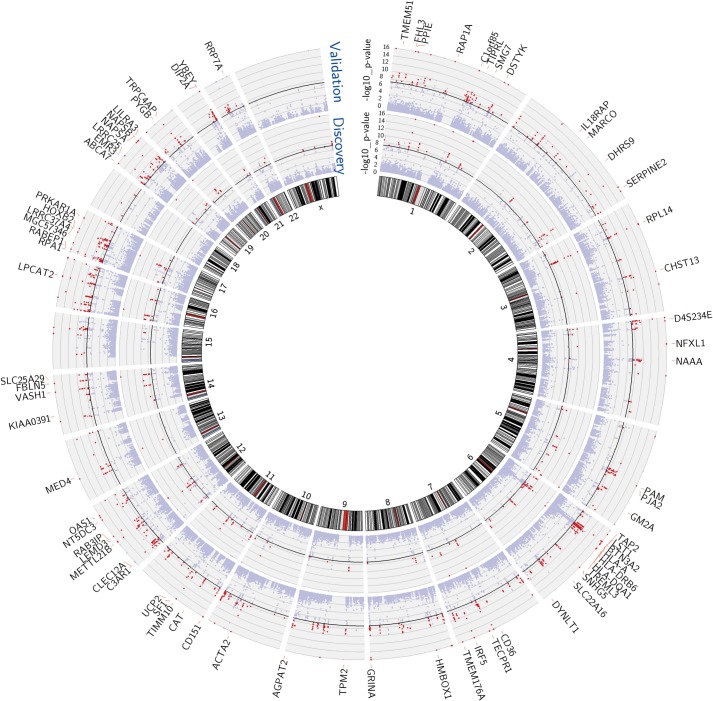
Multiple genes show both a transcriptional response to the vaccine and evidence of genetic regulation of gene expression (cis-acting eQTL) in both cohorts.Manhattan plots of the genotype-expression—log10 p-values across the genome for the discovery (inner circle) and validation (outer circle) cohorts. Each dot represents a SNP-transcript pair. Red dots indicate SNP-transcript pairs for which there is evidence of significant genotype-expression association (genotype p<5 × 10−8) and evidence of a transcriptional response to the vaccine (day effect p<0.05). The 78 genes that showed both properties in the two cohorts are shown in the outer margin.